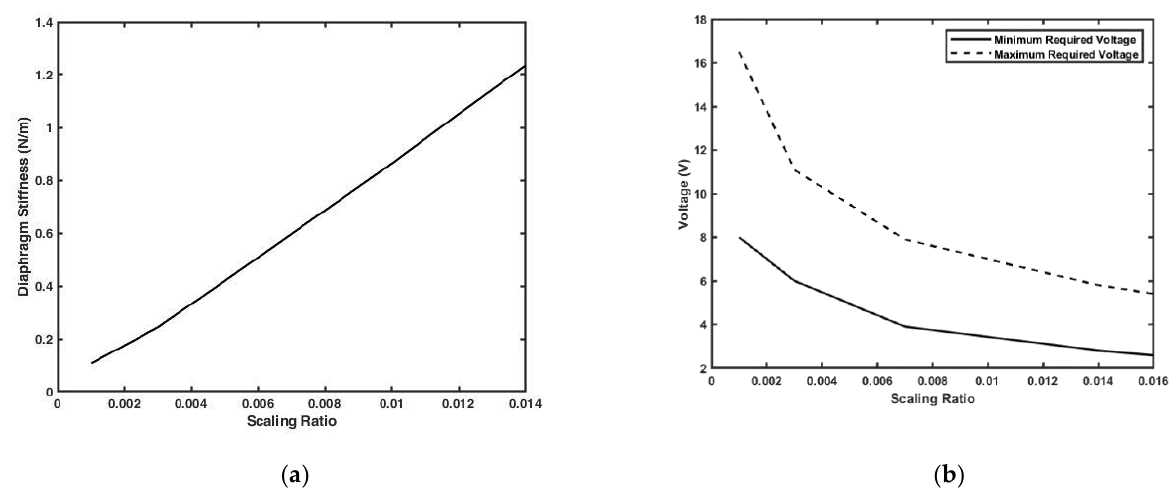
Figure 9. Actuator performance at different scaling factors obtained by COMSOL: ( a ) Diaphragm stiffness at different scaling factors.; ( b ) Minimum and maximum required actuation voltage at different scaling ratios.